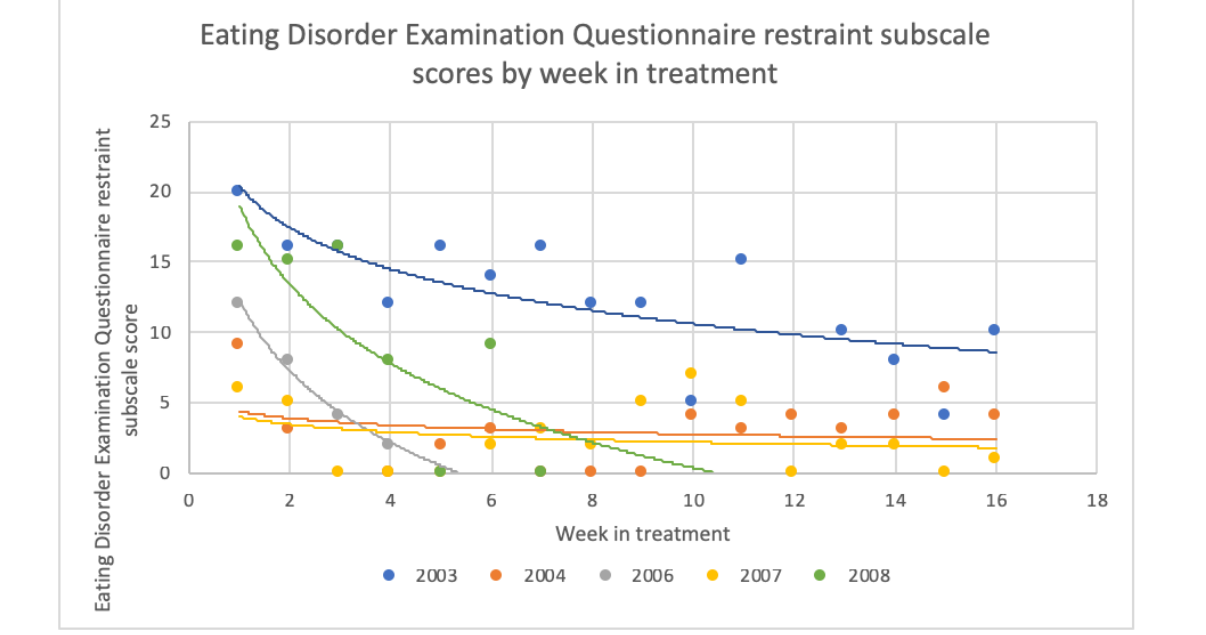
Figure 8. Change in weekly Eating Disorder Examination Questionnaire restraint subscale score throughout treatment.